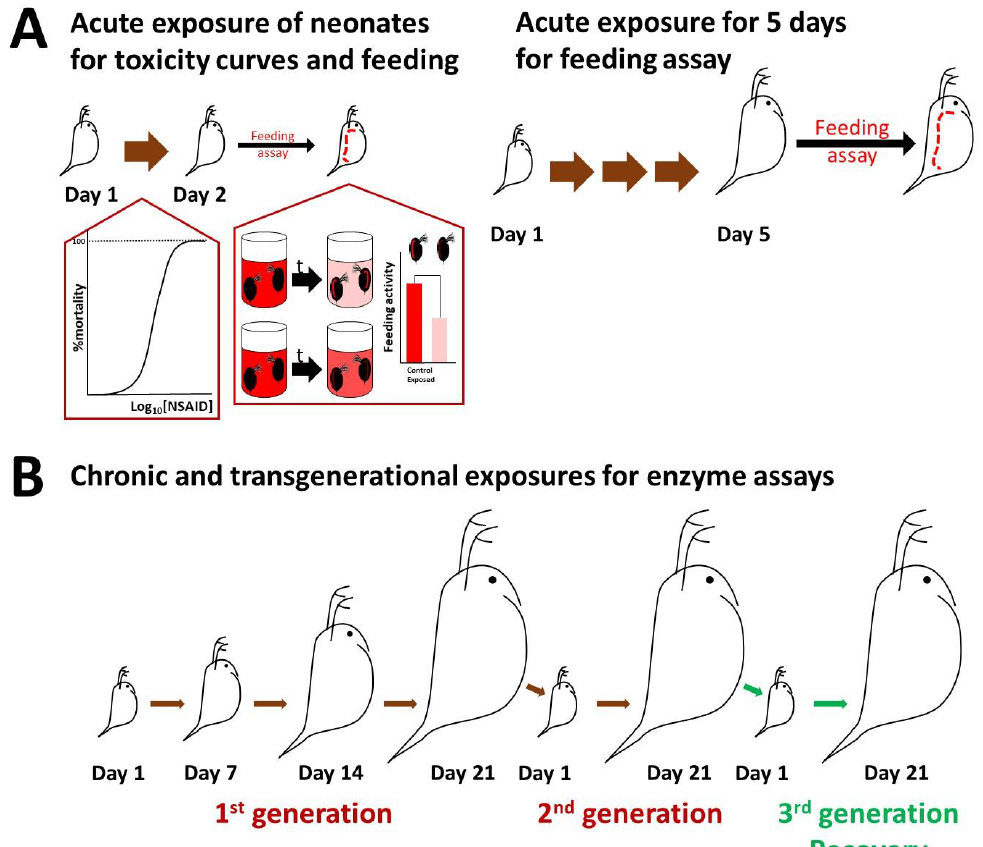
Figure 1. Experimental design. ( A ) Acute exposures in neonates and five-day-old daphnids to assess mortality and feeding. ( B ) Chronic and transgenerational exposures followed by a recovery generation for the quantification of enzyme activities. Figure created with BioRender.com. Brown arrows indicate exposure to NSAIDs and their combined mixture, while green arrows show recovery exposure in the absence of NSAIDs.